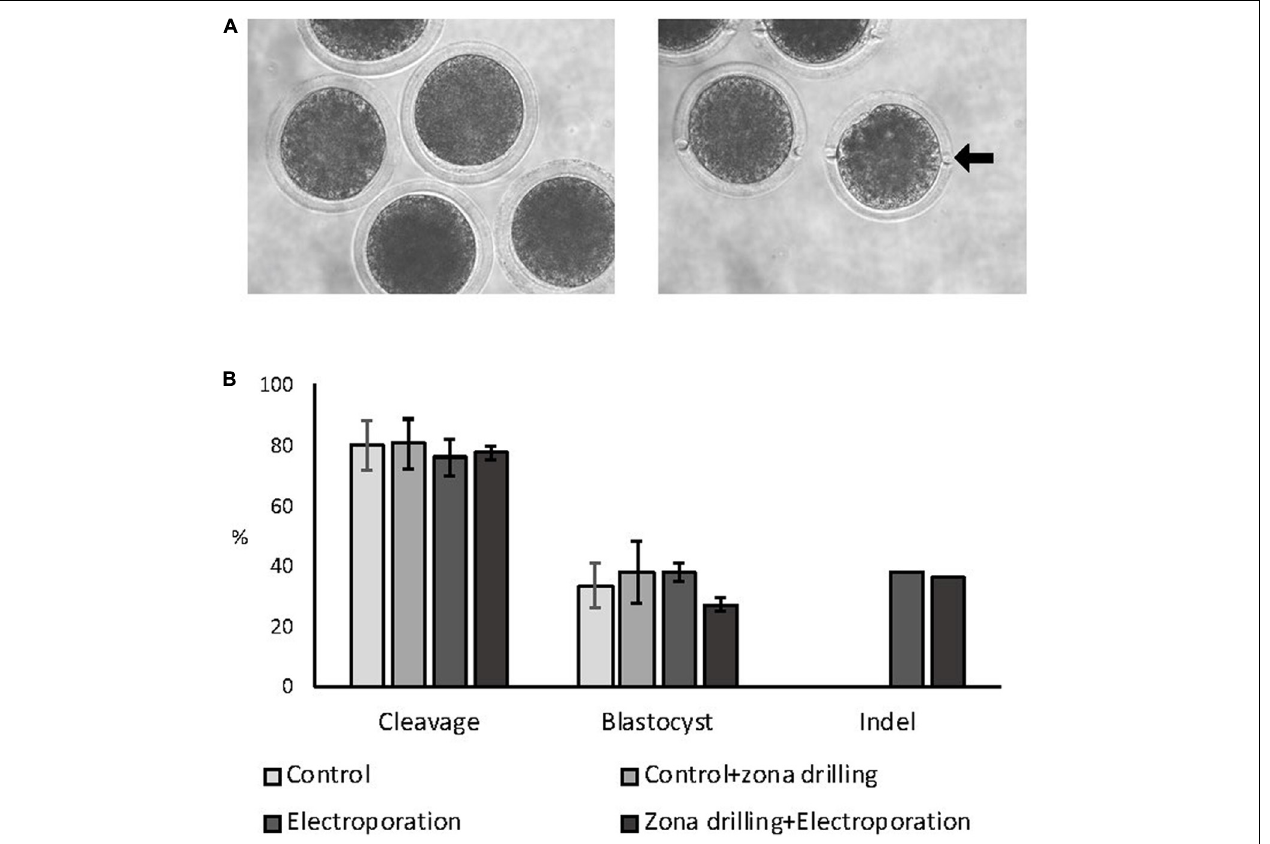
FIGURE 3 | Effect of zona drilling on electroporation efficiency of bovine zygotes. (A) Picture of intact (left) and zona drilled (right) embryos. Arrow indicates one of the two holes made in the zona pellucida of each embryo. (B) Cleavage and blastocyst rates (based on number of presumptive zygotes cultured) and indel rate (based on number of blastocysts sequenced) after electroporation with RNPs targeting the ZFX gene. No difference between groups were observed ( P > 0.05). The experiment was replicated three times. Sample size: control (no electroporation and no zona drilling) = 69 zygotes; control+zona drilling = 69 zygotes; intact electroporation = 45 zygotes; zona drilling+electroporation = 98 zygotes. Blastocysts sequenced: electroporation = 16; zona drilling+electroporation =